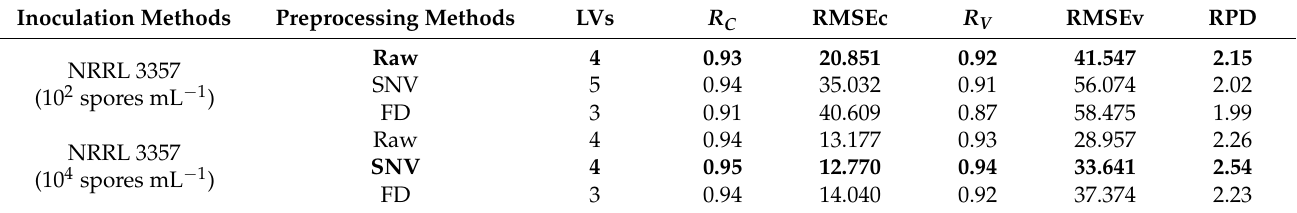
Table 3. Prediction results of AFB 1 in two types of culture methods based on full-band spectra.